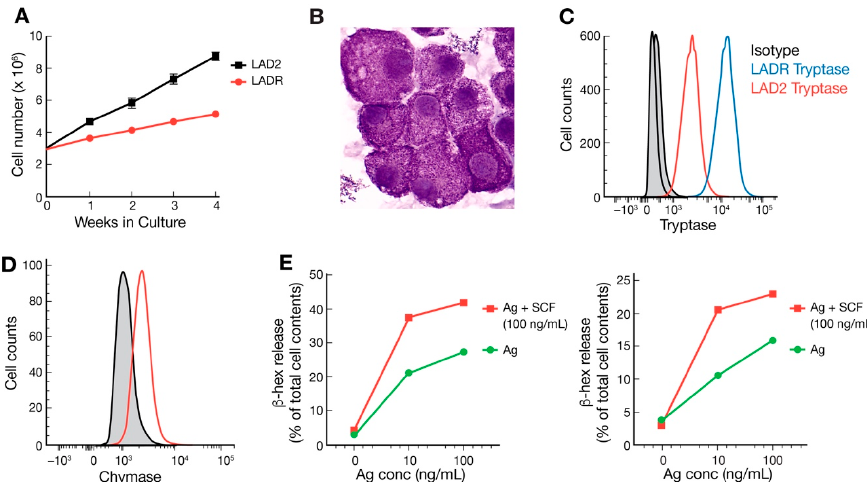
Figure 1. Cell proliferation, tryptase expression, chymase expression, degranulation, and beta-hexosaminidase ( β -hex) release of LADR (a second mast cell line) and laboratory of allergic diseases 2 (LAD2) cells. ( A ) LADR cell numbers (in red) doubled in 3–4 weeks compared with 1–2 weeks for LAD2 cells (in black), LADR cells appeared to expand in culture as a more advanced human mast cell line; ( B ) Wright–Giemsa staining of LADR cells ( × 630); ( C ) LADR cells (in blue) have log-fold higher granular expression of tryptase; ( D ) LADR cells express chymase (in red, and ( E ) LADR cell β -hex release (left panel) was twice the release of LAD2 cells (right panel) following Ag crosslinking alone and with SCF (stem cell factor)